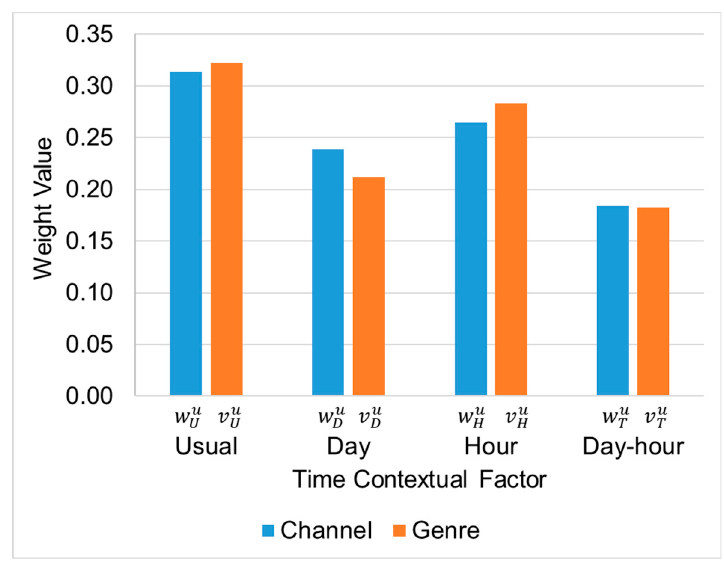
Figure 5. The average value of weight parameters, w u ’s and v u ’s.